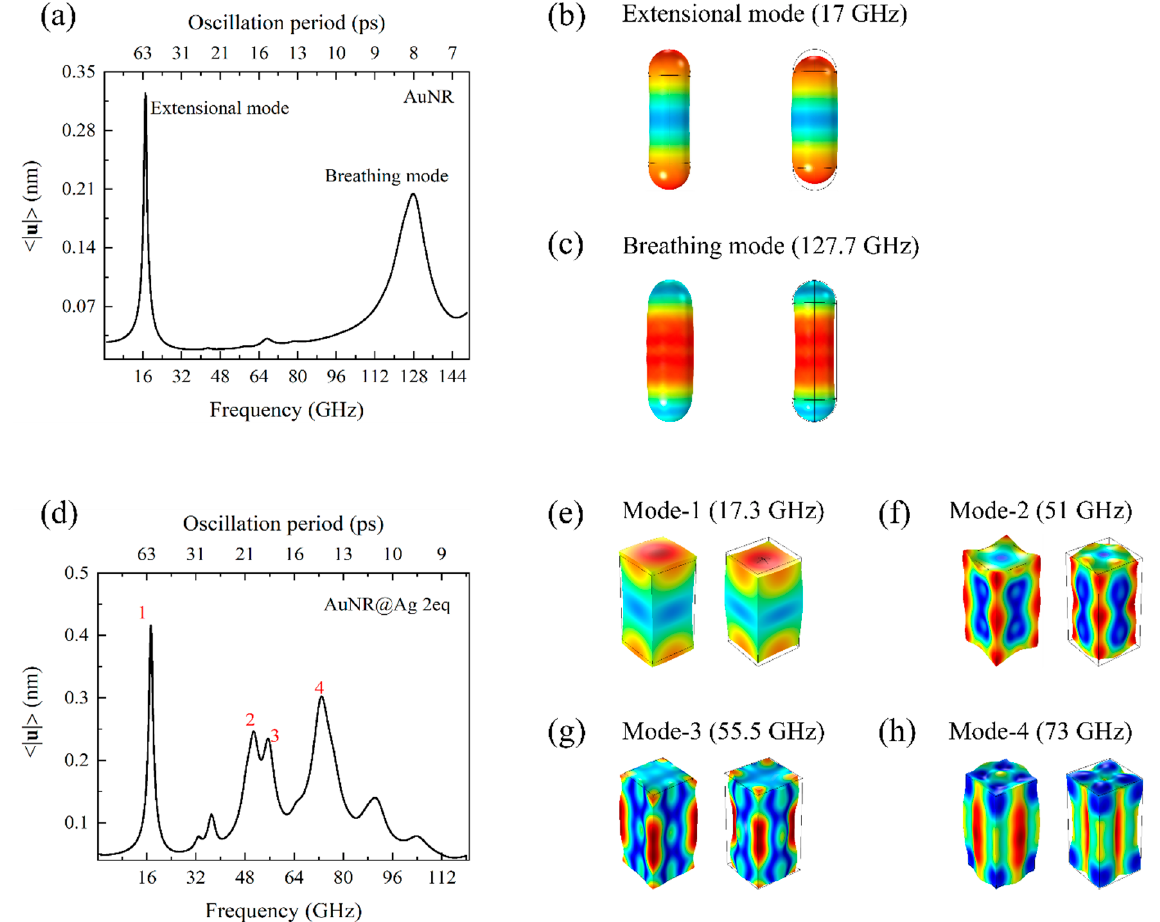
Figure 4. Calculated vibrational spectra of ( a ) AuNR and ( d ) AuNR@Ag 2eq NPs represented as the volume-averaged norm of the displacement vector, < > , as a function of frequency. Mode shapes that correspond to the dominant resonances identified in the spectrum are also shown via the 3D color plot of the norm of the vibrational displacement field. ( b , c ) depict the vibrational mode shapes of the extensional and breathing modes of the AuNR, respectively, whereas the modes dominating the AuNR@Ag 2eq vibration spectrum [labeled from 1 to 4 in ( d )] are also shown consecutively from ( e – h ). The two mode shapes at each mode frequency in ( b , c , e – h ) correspond to the maximum expansion (left) and compression (right) of the NPs. The wire frames in the 3D color plots represent the NP shape at equilibrium and the red and blue colors represent the maximum and minimum deformations, respectively. For clarity, the deformations are magnified by a factor of 5 in all of the 3D color